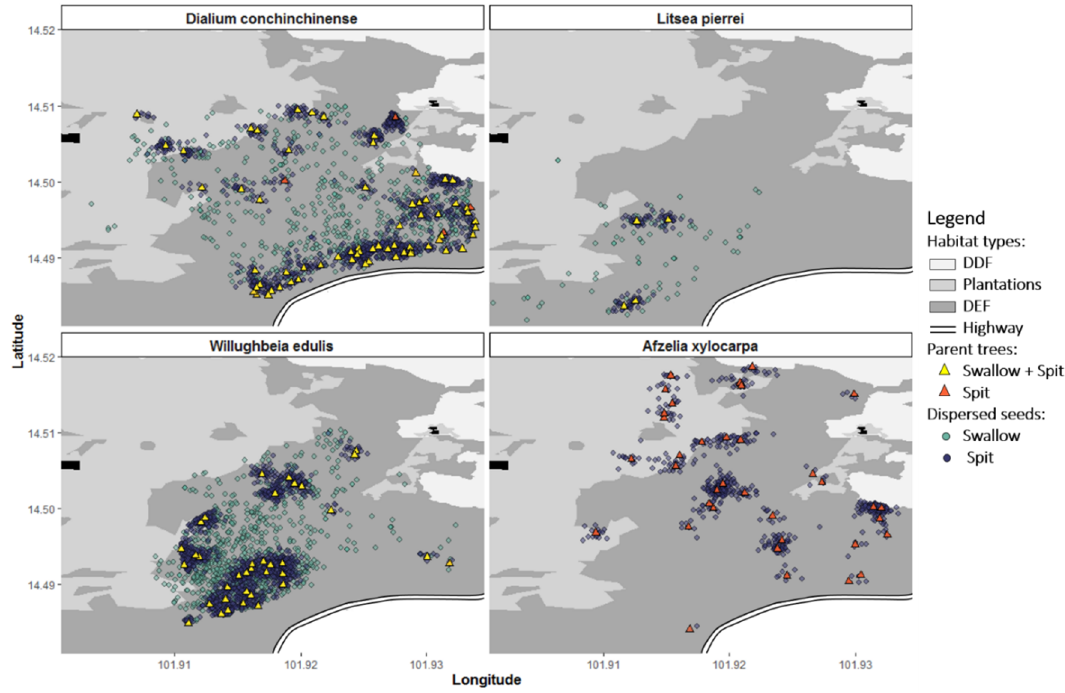
Figure 5. Spatial distribution of the simulated dispersed seeds of the selected species via swallowing (defecated) or cheek pouch (spat out) by the northern pigtailed macaques within the degraded forest fragment of Sakaerat.